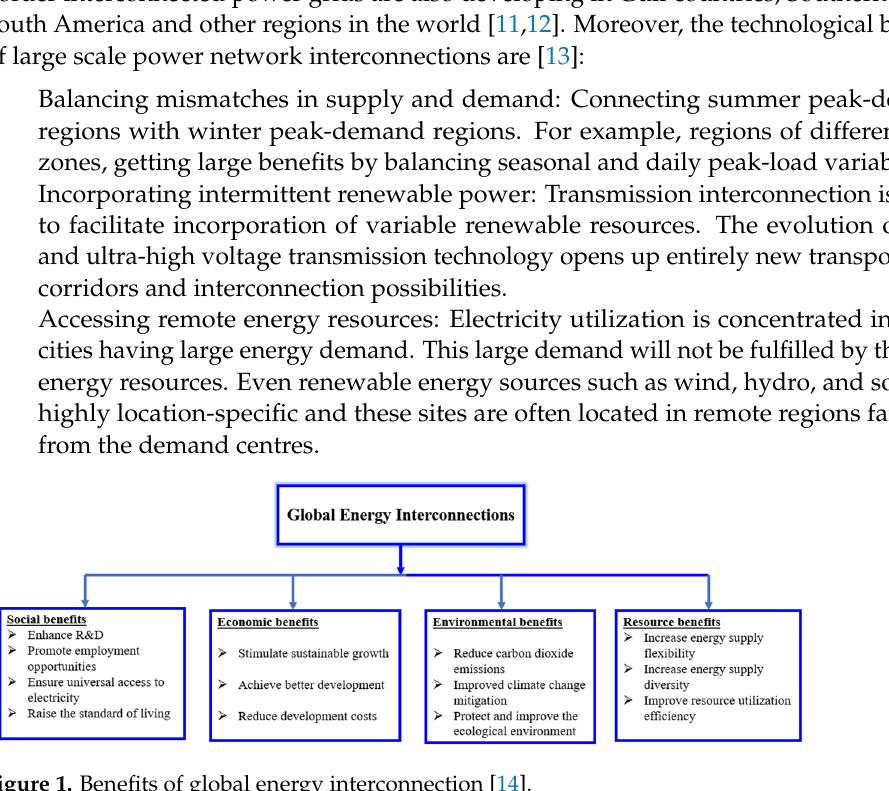
Figure 1. Benefits of global energy interconnection